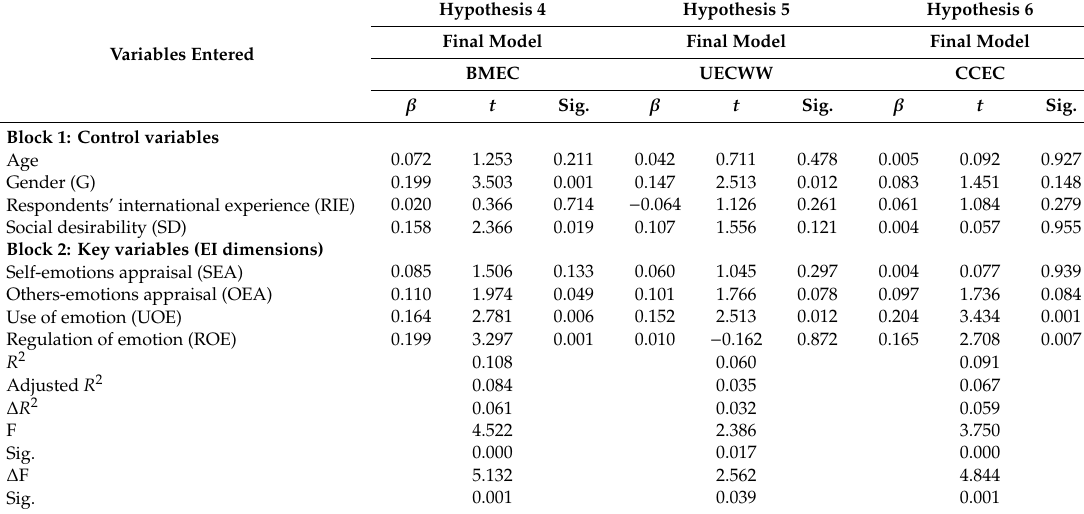
Table 6. Regression results (H 4 , H 5 , and H 6